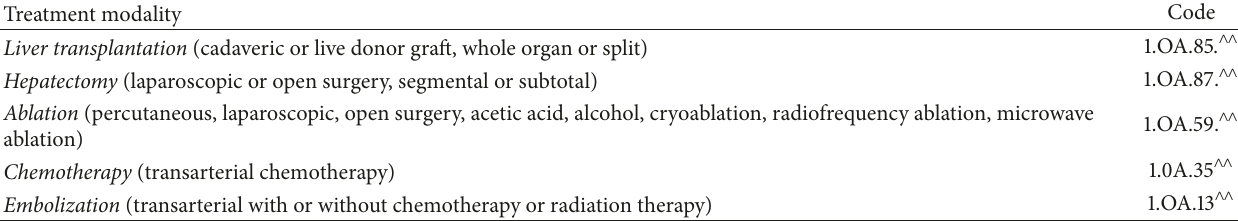
Table 1: Summary of codes used to identify treatment modalities of Canadian patients with primary hepatic cancer during the period between 2002 and 2013. Codes for liver transplantation, hepatic resection (segmental or subtotal), ablation, and embolization with or without chemotherapy or transarterial radiation were selected from the Canadian Classification of Health Interventions manual